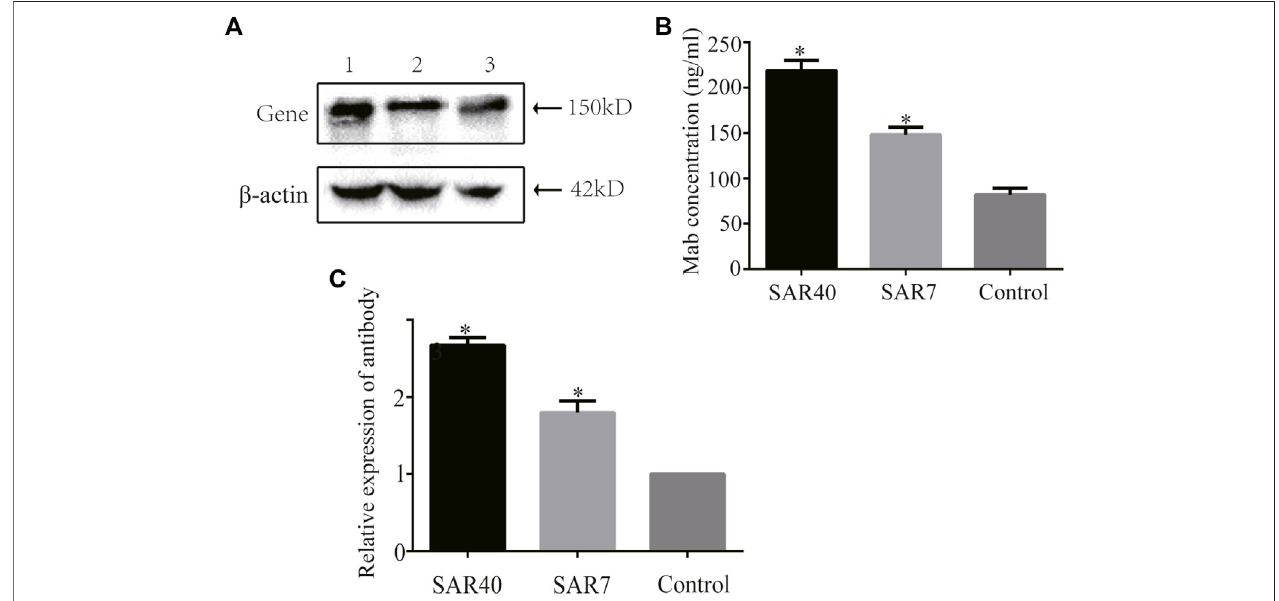
FIGURE6| Analysisofadalimumabantibodyexpression ofdifferentconstructsinCHOcells.Thevectorscontainingadalimumabantibodygeneweretransformed into CHO cells, respectively. Cells supernatant was collected for analysis. (A) Adalimumab antibody expression was detected by Western blot. Lane 1, pIRES-mAb- SAR40; Lane 2, pIRES-mAb-SAR7; Lane 3, pIRES-mAb. (B) Expression of the adalimumab antibody was detected by ELISA. (C) Relative expression of adalimumab antibody. The results are the mean values obtained for three independent experiments, and the standard deviation is indicated (* p <